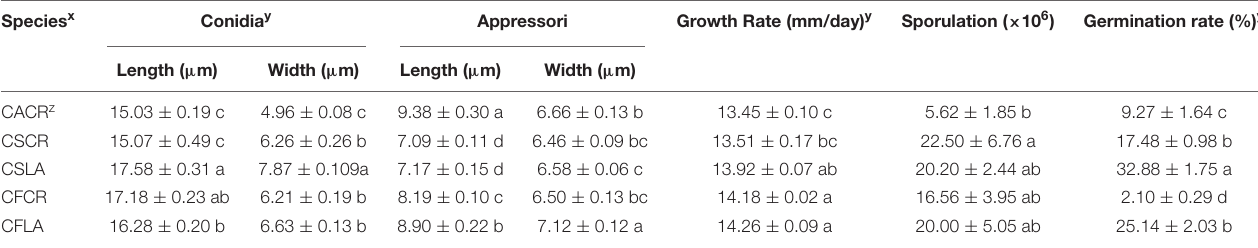
TABLE 4 | Disease spot diameters (mm) of Colletotrichum species from leaf and crown of strawberry toward leaves of different strawberry varieties. Colletotrichum spp.